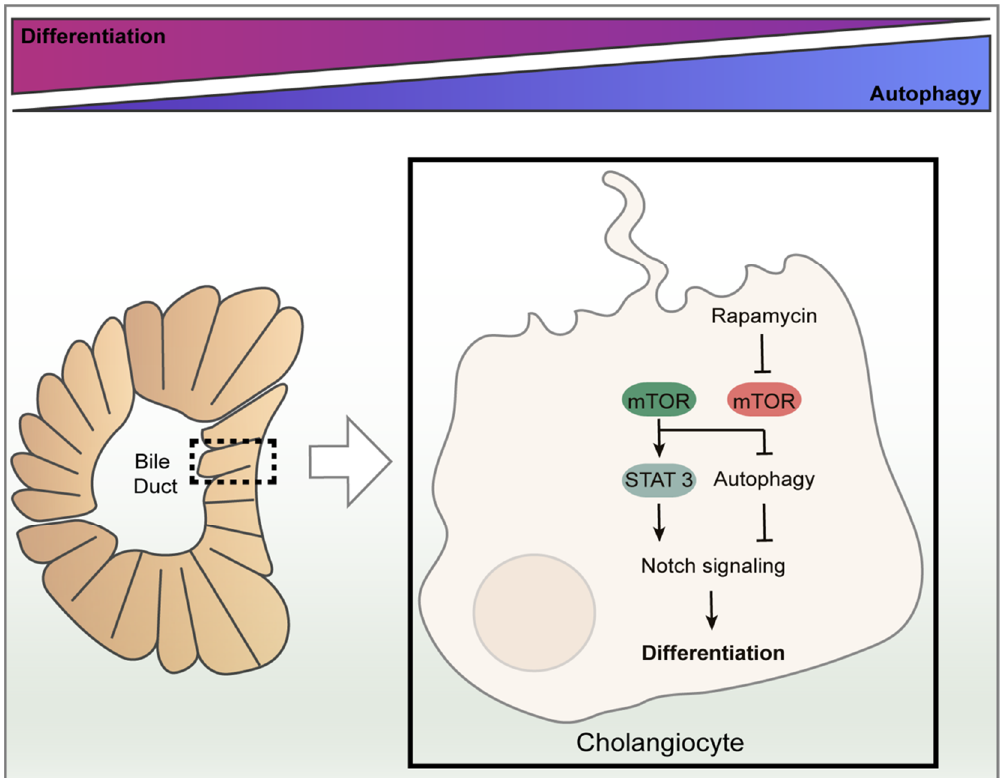
Figure 5. The role of autophagy on biliary epithelium differentiation and homeostasis. Autophagy is involved in the maintenance and functions of progenitory cells in the liver (HPC). It negatively correlates with biliary tree formation, it decreases in the early stages of HPC development while it increases in the late stages. HPC differentiation to cholangiocyte is controlled by the Notch signaling pathway. In cholangiocytes, the under nutrient-rich condition or absence of rapamycin, mTOR blocks autophagy resulting in an increased Notch-STAT3 cascade signaling pathway and promoting cellular differentiation. On the contrary, autophagy induction via rapamycin (an mTOR inhibitor) or nutrient deprivation attenuates the Notch signaling pathway resulting in a reduced biliary differentiation.